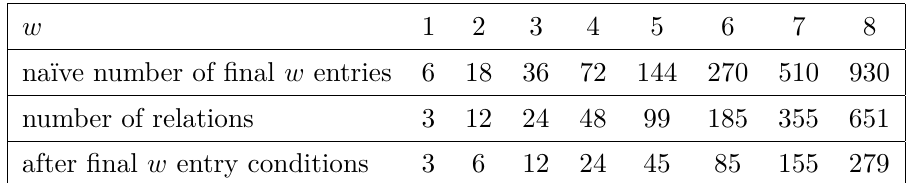
Table 4. Before imposing the final w entry relations, the “naïve” number of final w entries is 6 times the actual number of final entries at weight w − 1 , because one can put any of the 6 symbol letters in front of an independent w − 1 final entry. The number of relations required is the difference between this number and the actual number of final entries at weight w .